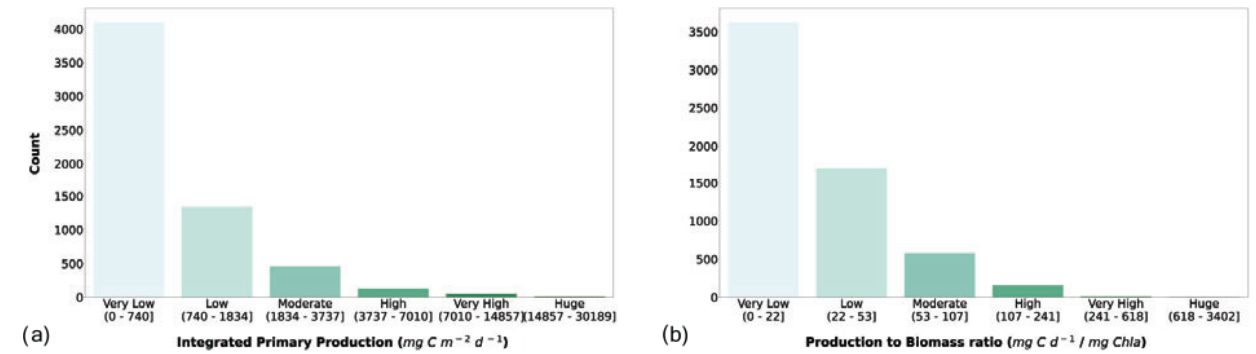
Figure 8. (a) Depth-integrated phytoplankton primary production and (b) production-to-biomass ratio classes. The bar color intensity reflects the magnitude of the class values.